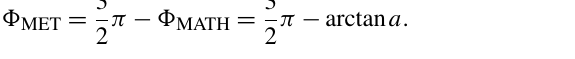
Figure 10. An example wake centerline detection in an ambiguous case.